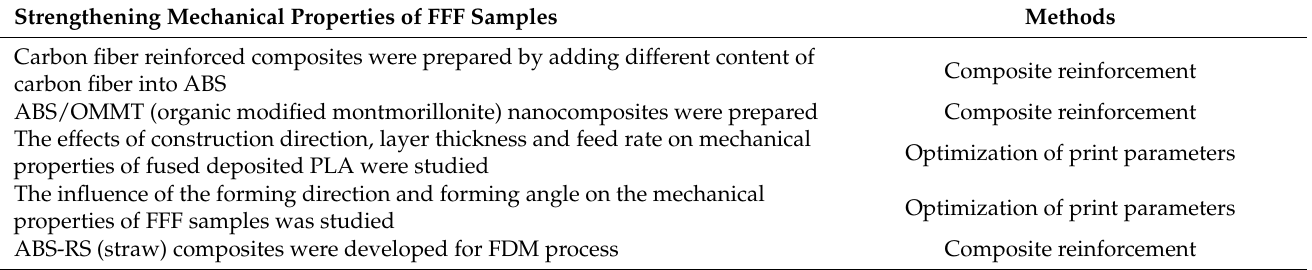
Table 1. Research on strengthening mechanical properties of FFF